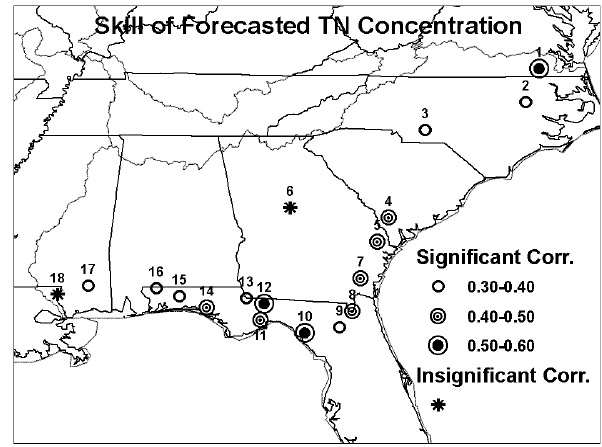
Figure 5. Correlation between observed TN concentration and fore- casted TN concentration for those days with TN loadings being Figure 5: Correlation between observed TN concentration and forecasted TN concentration for 41 available in the WQN database. those days with TN loadings being available in the WQN database. 42